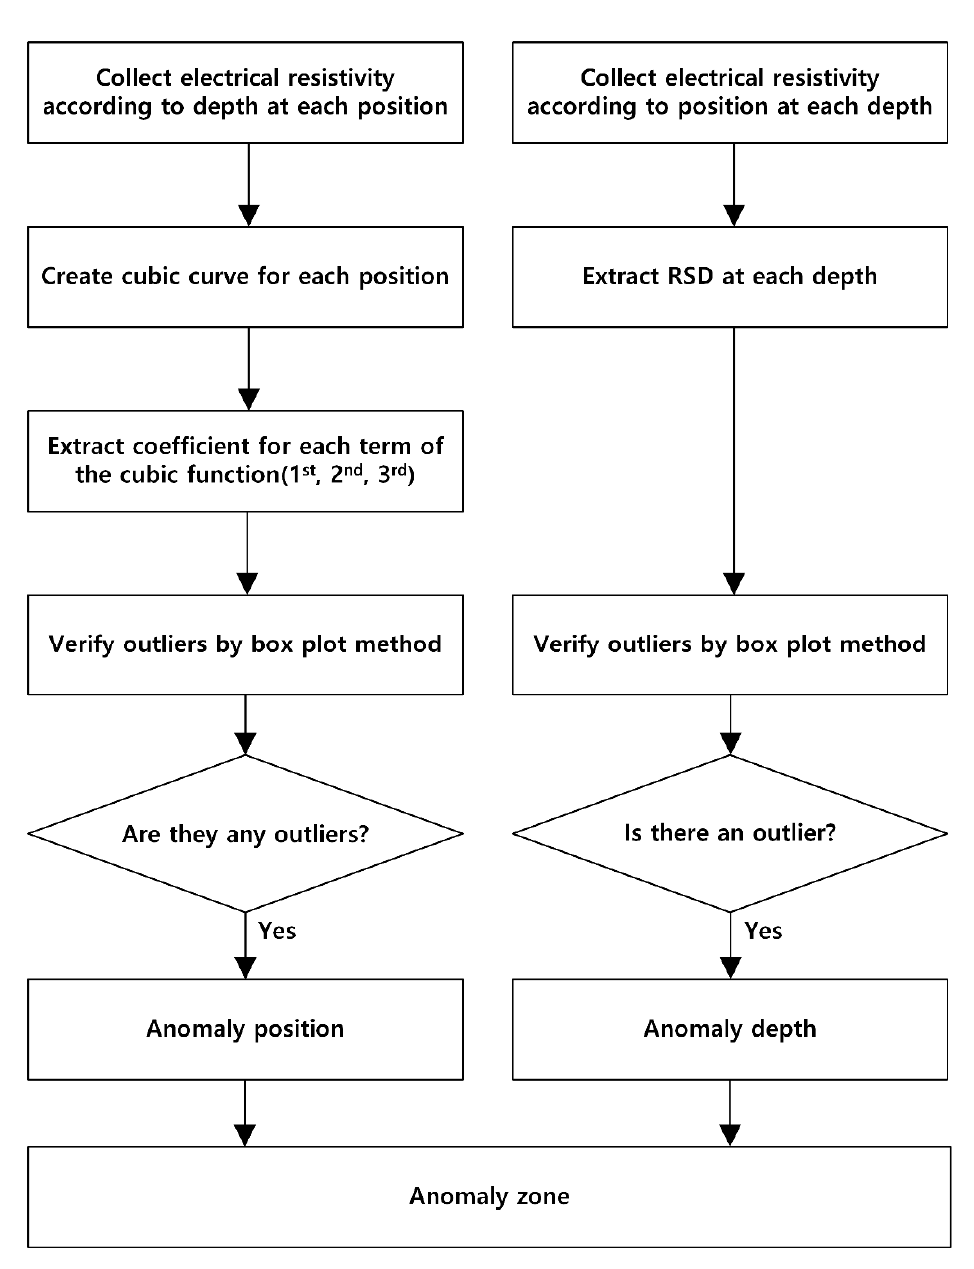
Figure 4. Procedure for verifying anomaly zones.